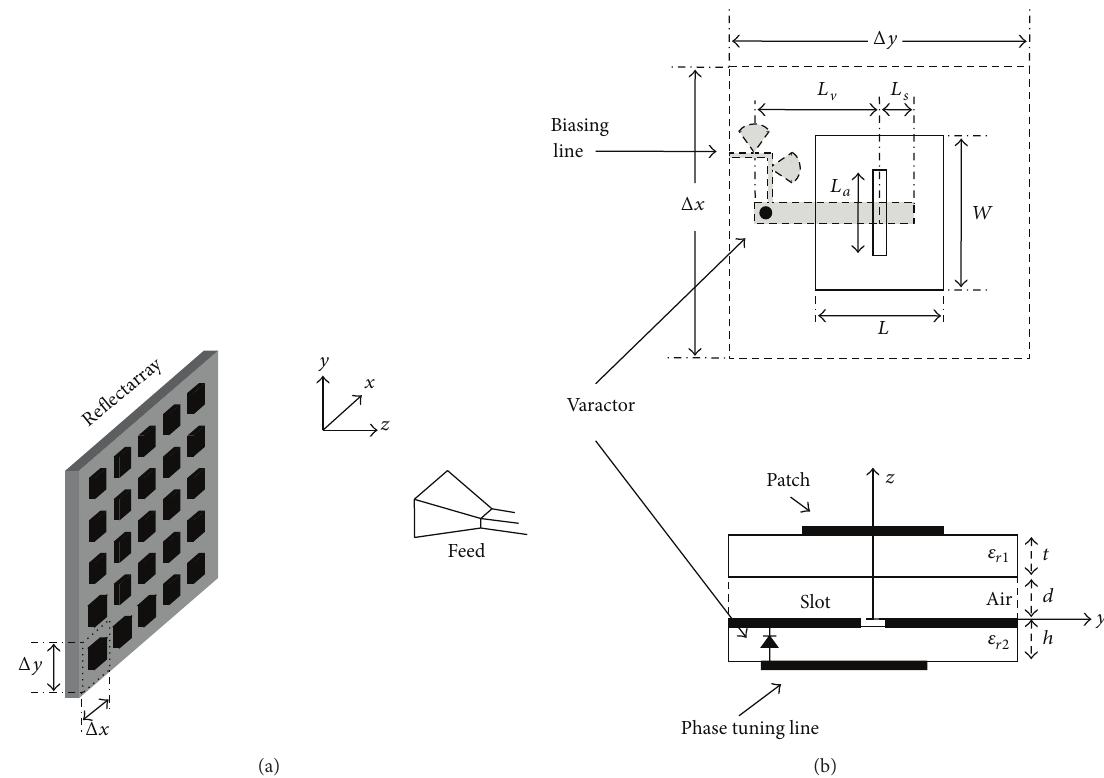
Figure 1: (a) Reflectarray antenna and (b) aperture-coupled reconfigurable reflectarray cell.